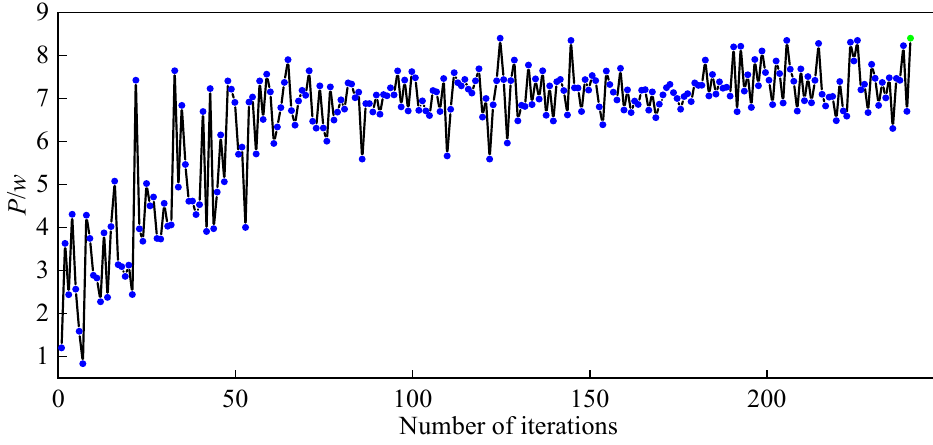
Figure 11. Output power optimization iterative process.